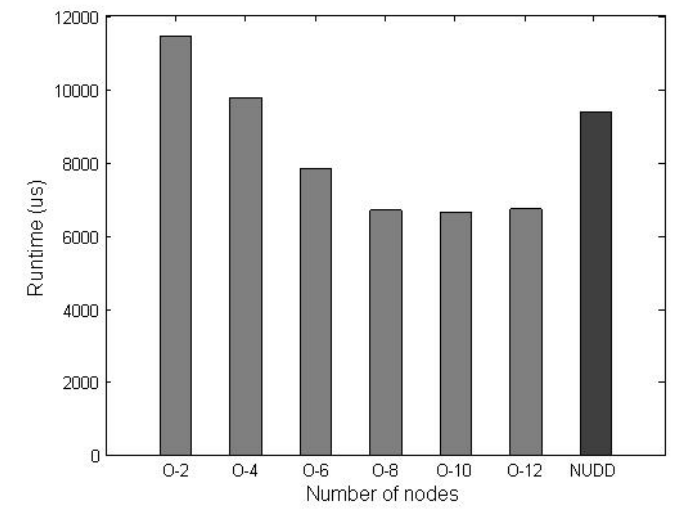
Figure 7. The number of subdomains was set to